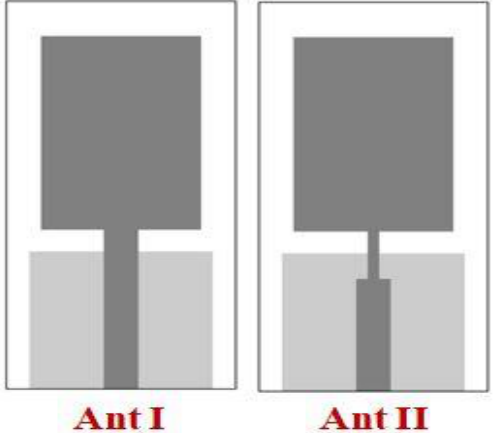
Figure 6. Evolution of the antennas linked with P2 to P9.